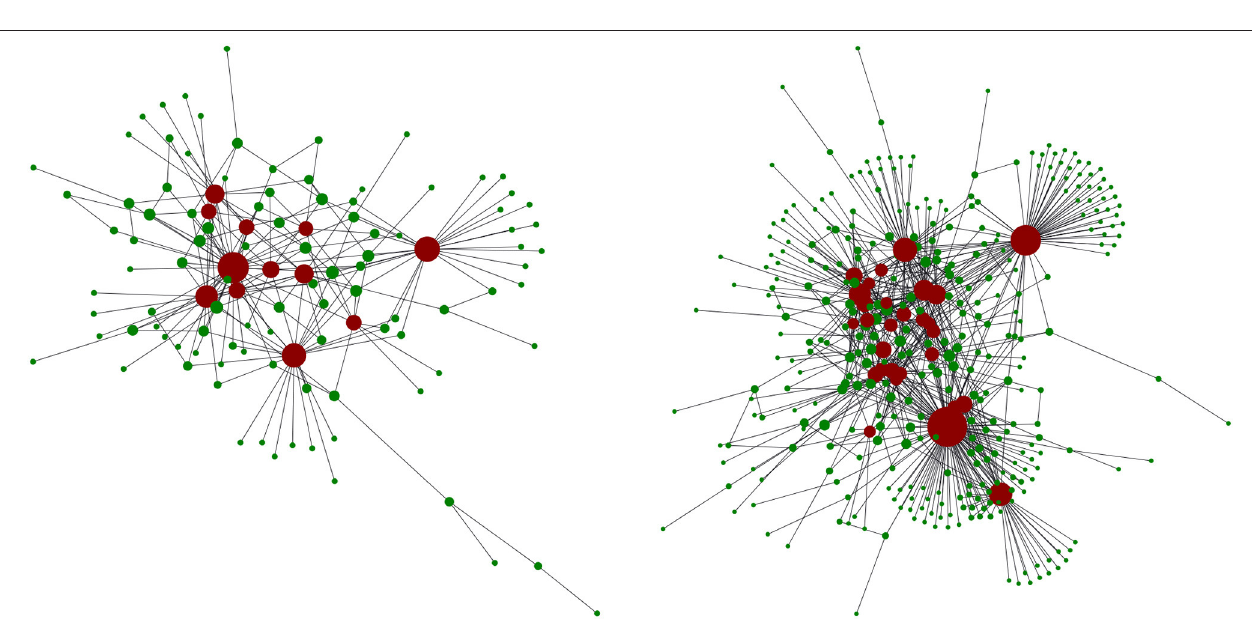
any two BLN users will search for a short(est) path; at the same time, nodes have the incentive to become as central as possible, in order to maximize the transaction fees they can earn.